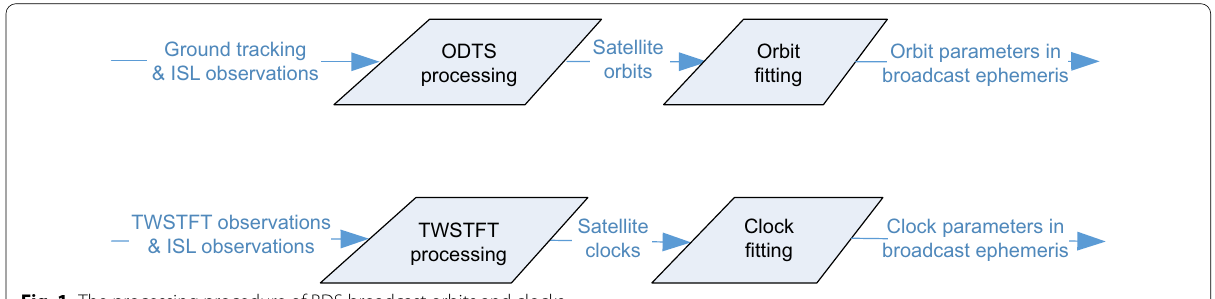
Fig. 1 The processing procedure of BDS broadcast orbits and